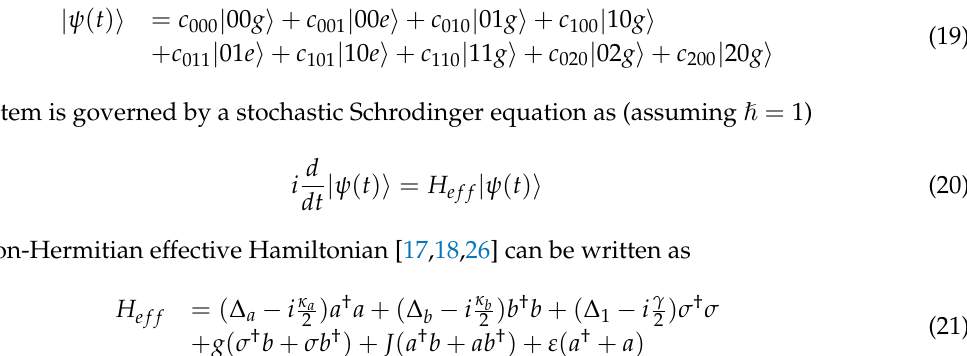
g ( 2 ) ( 0 ) as a function of scaled detuning 10 ∆ = 0 for ( a ) J = 3 κ a 1 . Other parameters are the same as in Figure 6a.